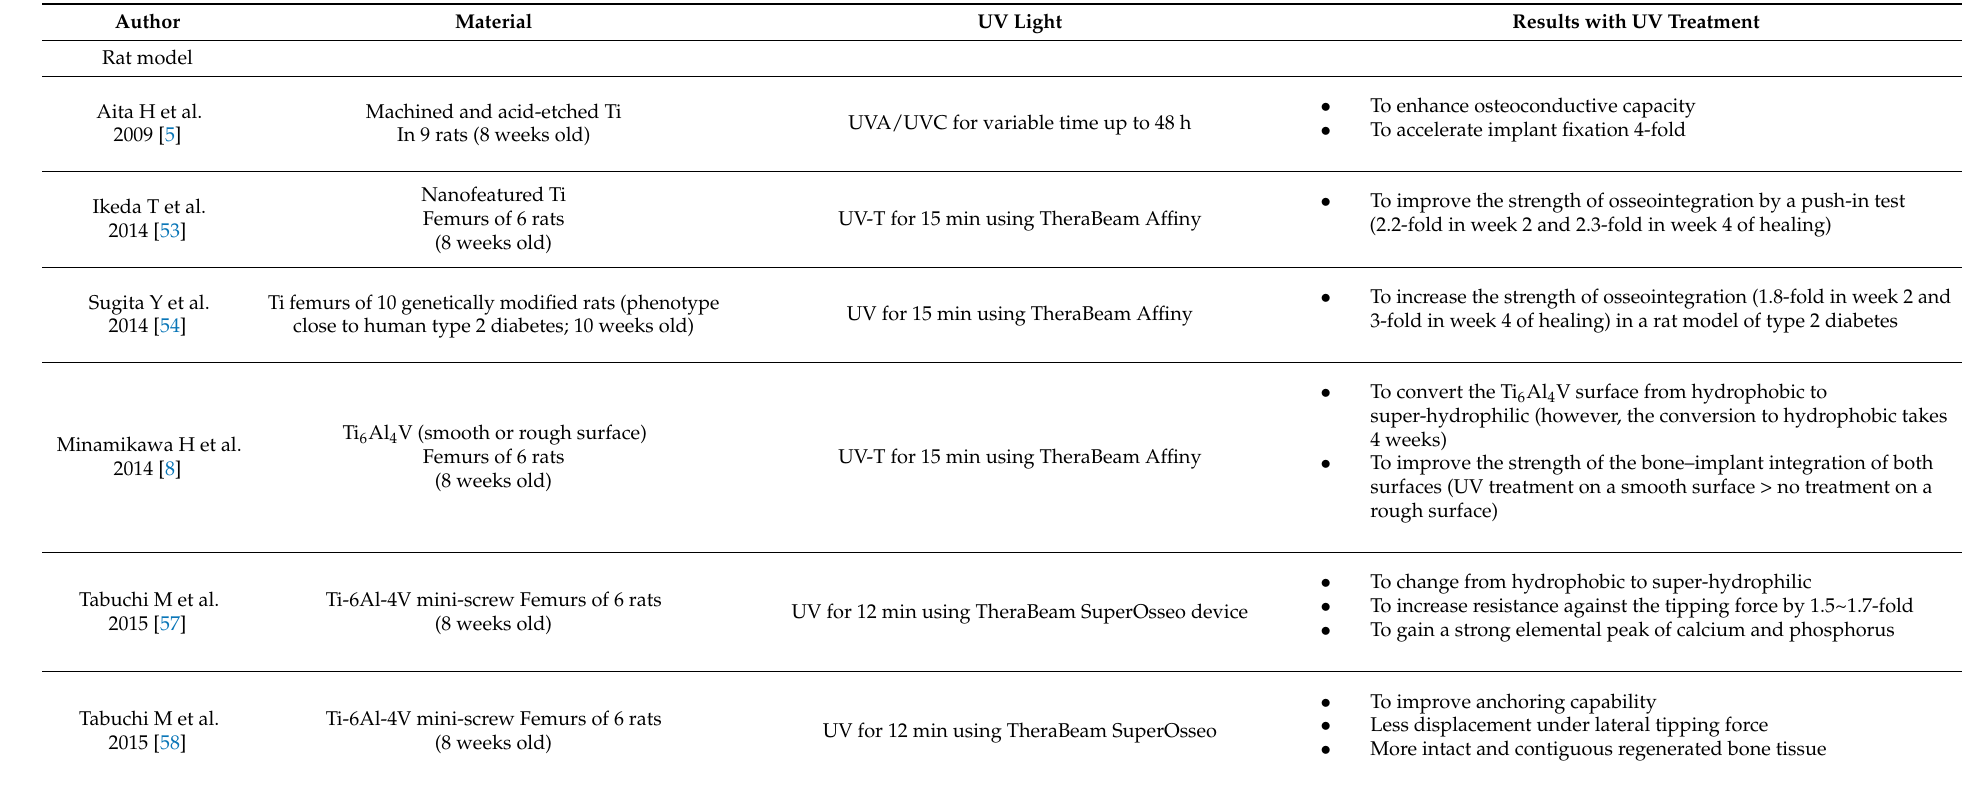
Table 2. Preclinical animal studies of